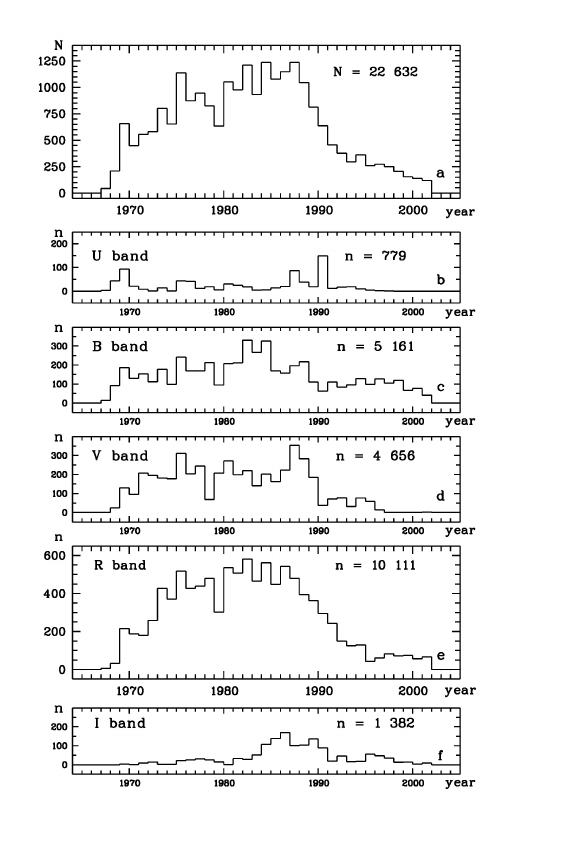
Figure 1. The total number of astrophotoplates and their number obtained in U, B, V, R, I photometric systems in different